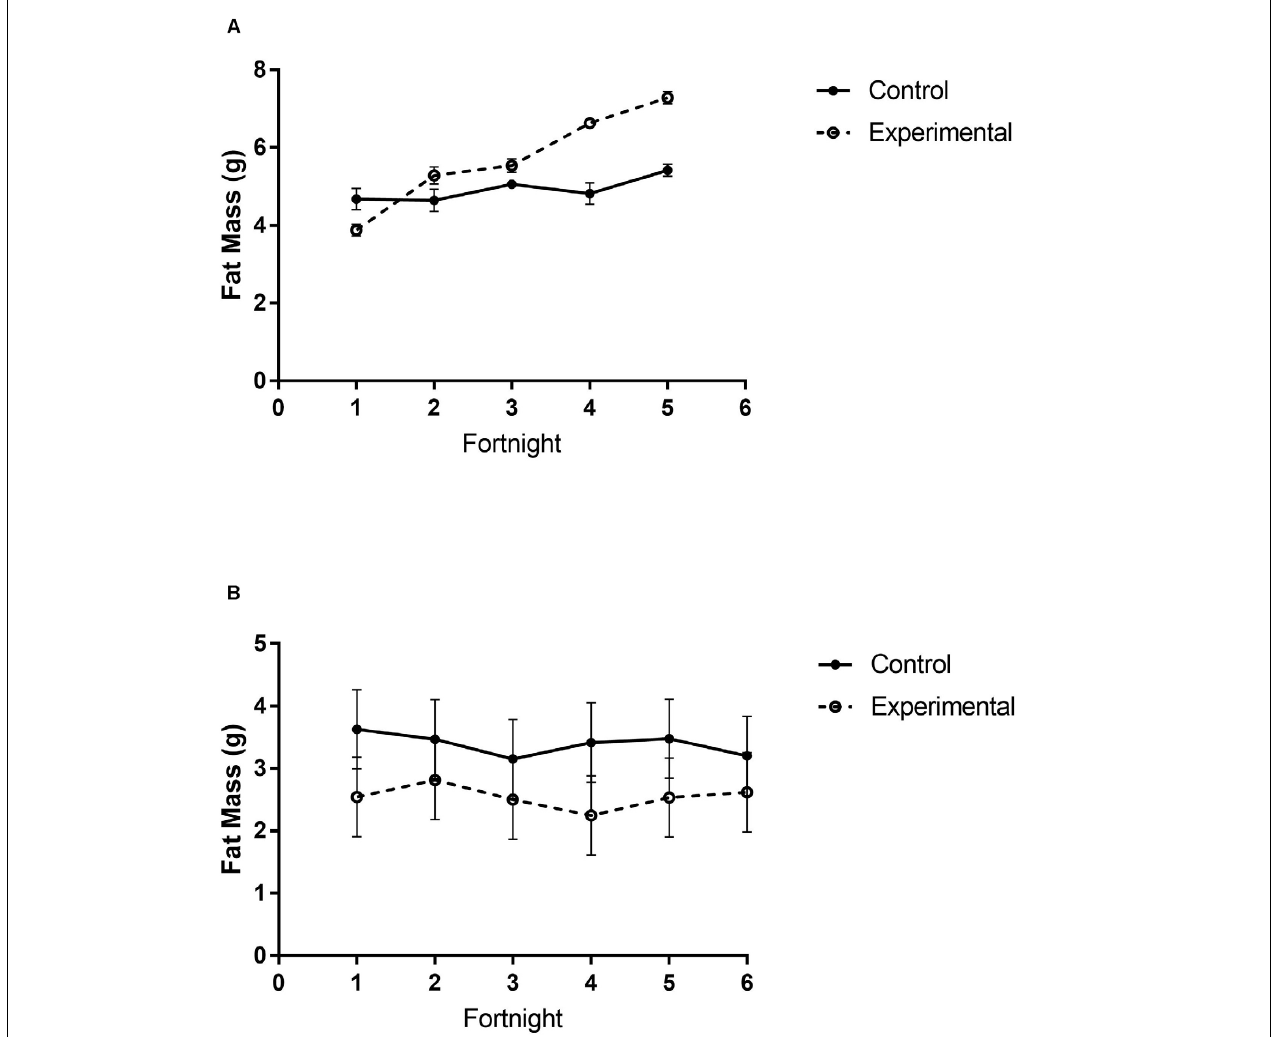
FIGURE 3 | Fat mass content of white-throated sparrows exposed to (A) low-frequency inclement weather conditions (study 1) or (B) high-frequency inclement weather conditions (study 2). (A) Experimental birds had higher fat mass content. (B) Control birds had higher fat mass content. Points indicate mean total mass values and error bars indicate SEM.